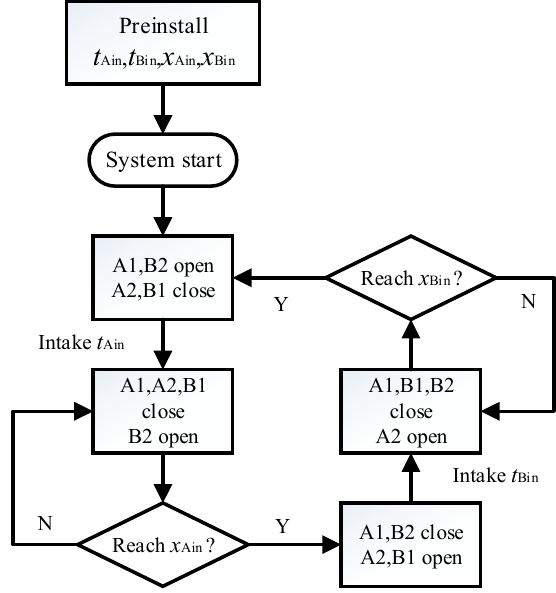
Figure 3. Schematic of position-time control